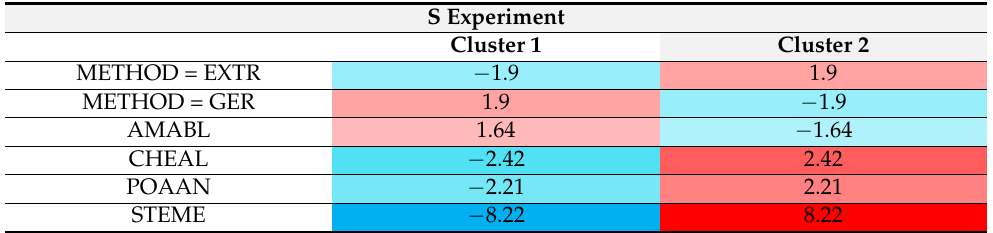
Table 3. Description of the relationship between the quantitative weight of data species and the categorical variable method in S